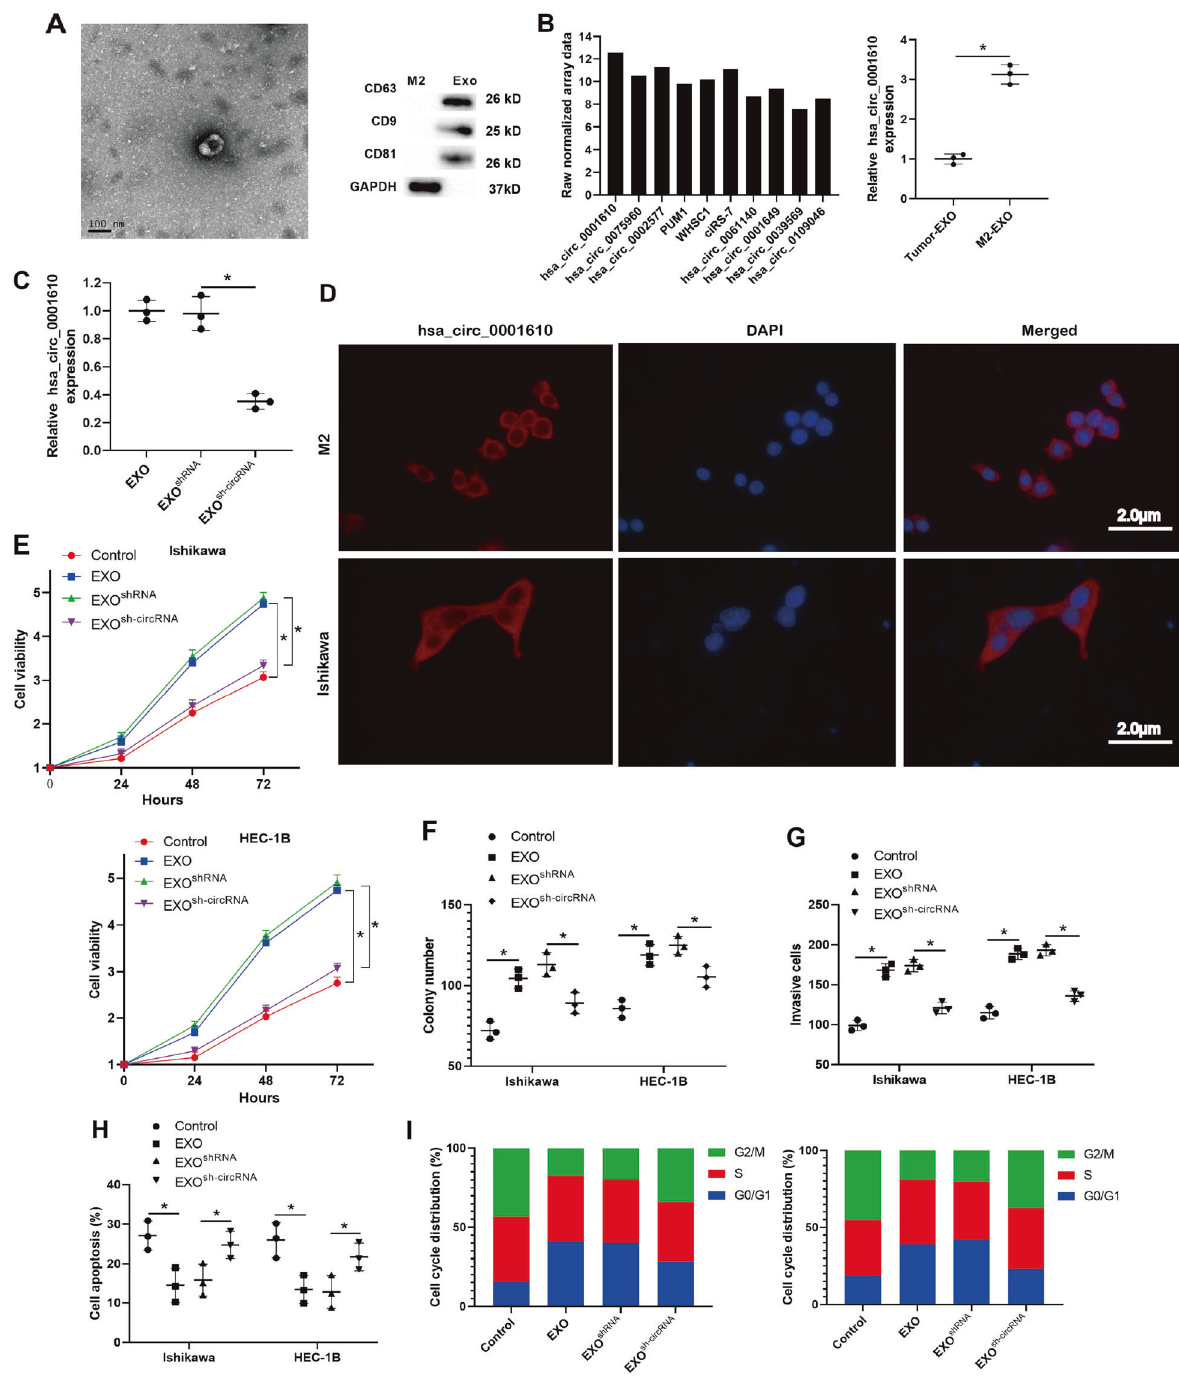
Fig. 3 Exosomal hsa_circ_0001610 mediated the weakening effect of M2-polarized macrophage-derived EXOs on the radiosensitivity of EC cells. A Representative transmission electron microscopy image of M2-polarized macrophage-derived EXOs (Scale bar = 100 nm). B Left: the expression pro fi les of ten candidate circRNAs in M2-polarized macrophage-derived EXOs were generated by a circRNA microarray analysis. Right: the expression level of hsa_circ_0001610 in EC cell-derived EXOs and M2-polarized macrophage-derived EXOs was measured by qRT- PCR. C The expression level of hsa_circ_0001610 in M2-polarized macrophage-derived EXOs (EXO), EXOs that silenced hsa_circ_0001610 (EXO sh-circRNA ), and the negative control of EXO sh-circRNA (EXO sh-RNA ) was measured by qRT-PCR. D The cellular localization of hsa_circ_0001610 in M2-polarized macrophages and Ishikawa cells (Scale bar = 2.0 μ m). E – I EC cell lines (Ishikawa and HEC-1B) were normally cultured (Control) or treated with EXO/EXO sh-RNA /EXO sh-circRNA , and then treated with 4 Gy irradiation. Cell E viability, F proliferation, G invasion, H apoptosis, and I cell cycle were measured. * p <